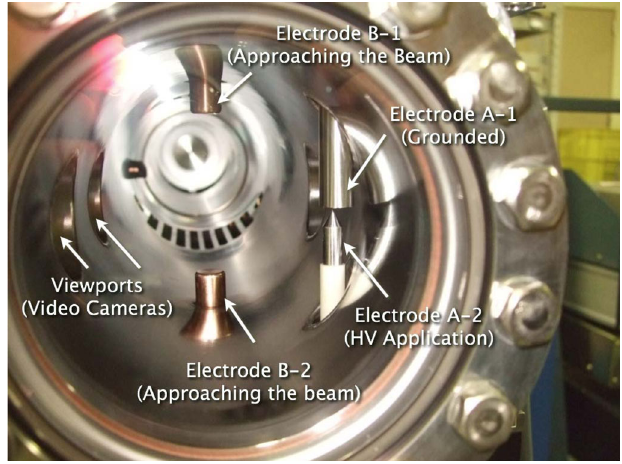
FIG. 1. (Color) Image of the interior of the discharge